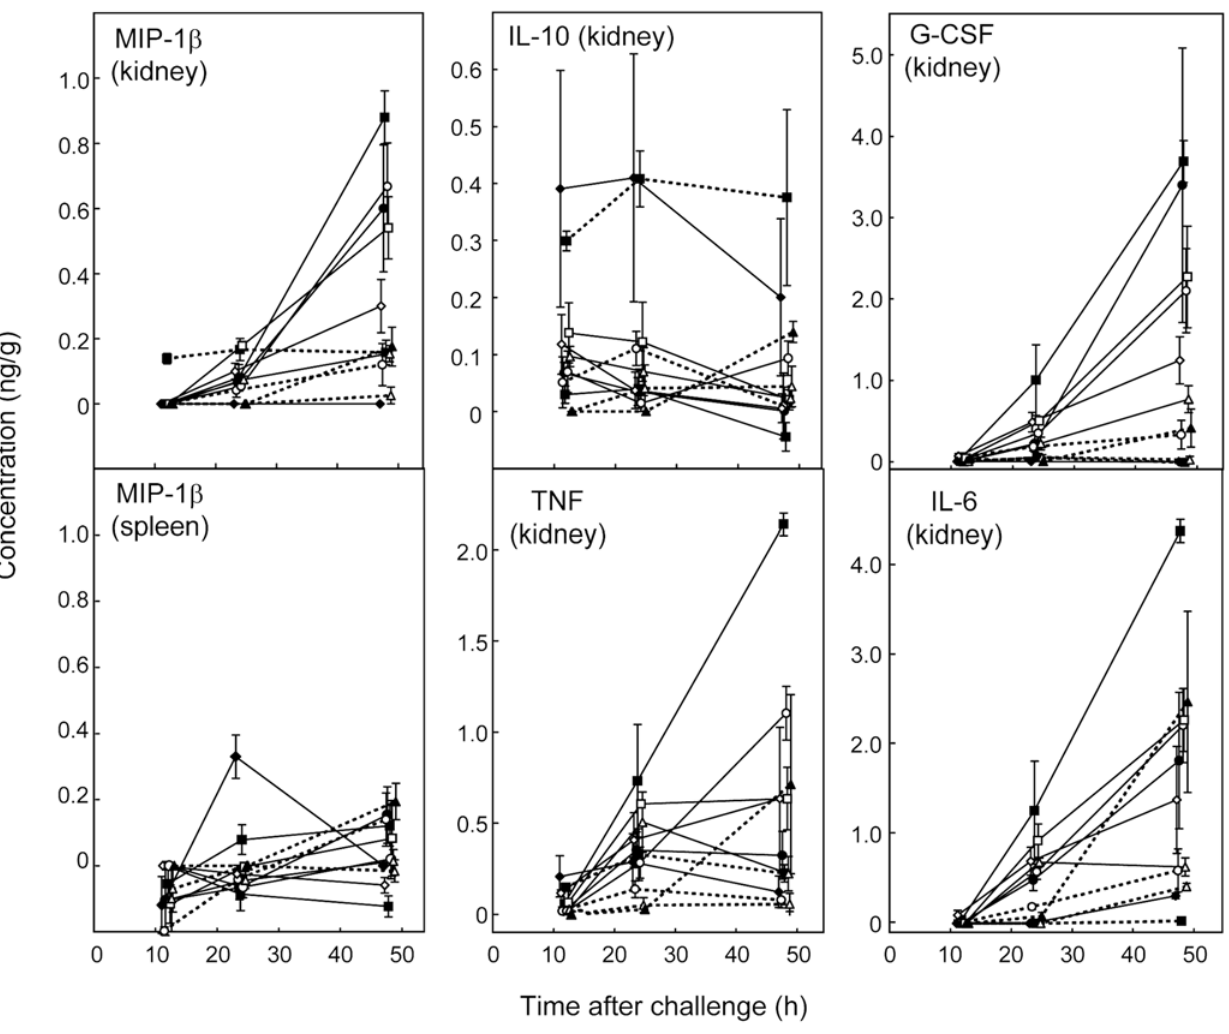
Figure 6. Time course of concentrations (ng/g) of the chemokine MIP-1 b in kidney and spleen samples, and of four cytokines measured in kidney samples. Among the latter only IL-10 was measurable in spleen samples (see text). Details as in Fig. 4.